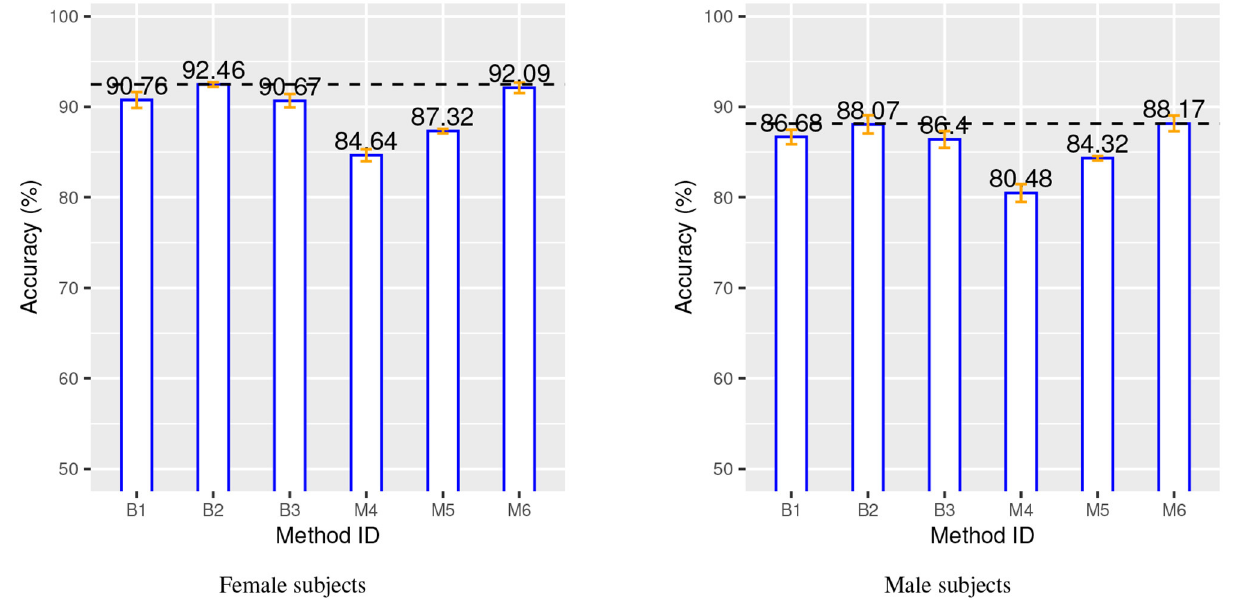
FIGURE 3 | Classification accuracy for both gender groups over 10-time repeated 10-fold cross-validation. Blue bars, orange bars and dashed lines represent, respectively, accuracy, standard deviation, and best